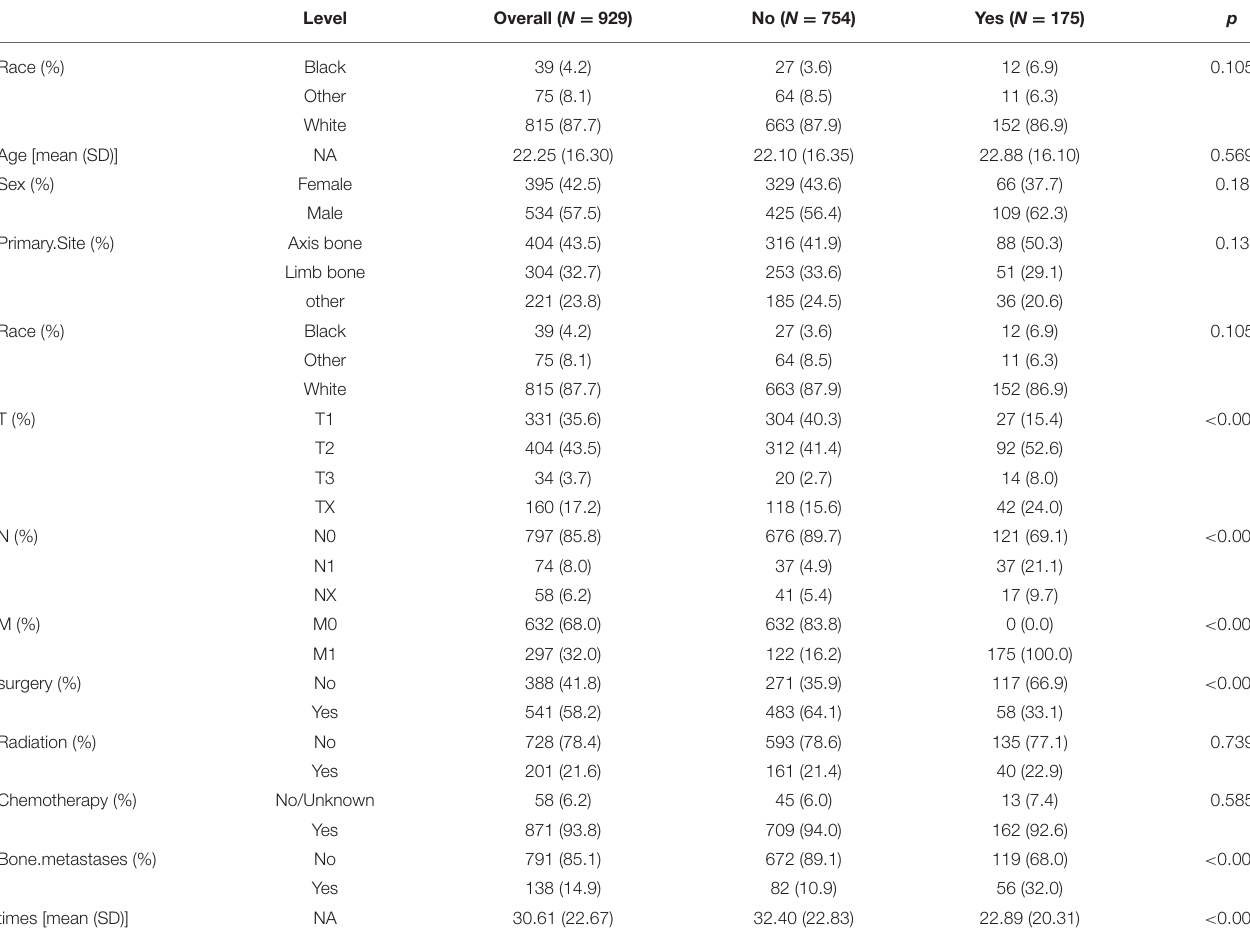
TABLE 2 | Baseline table of patients in the Ewing sarcoma lung metastasis group vs. the no lung metastasis